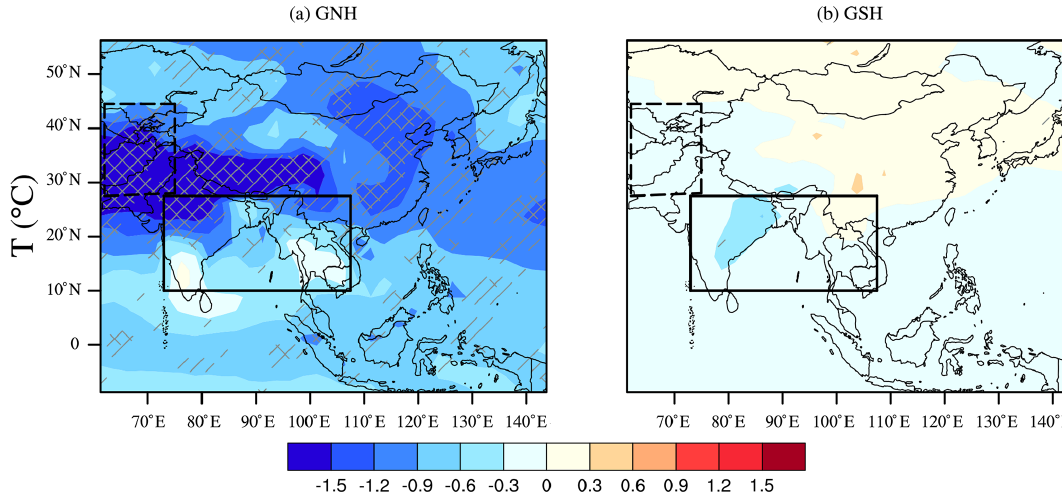
Figure 6. Spatial distribution of the temperature anomalies in the eruption year with respect to the mean of 5 years before the eruption. The solid and dashed black boxes indicate the relatively wettest area (RWA) and relatively driest area (RDA), respectively, as shown in Fig. 1. The gray slashes and cross signs indicate the significant results at the 95% and 99% confidence levels.